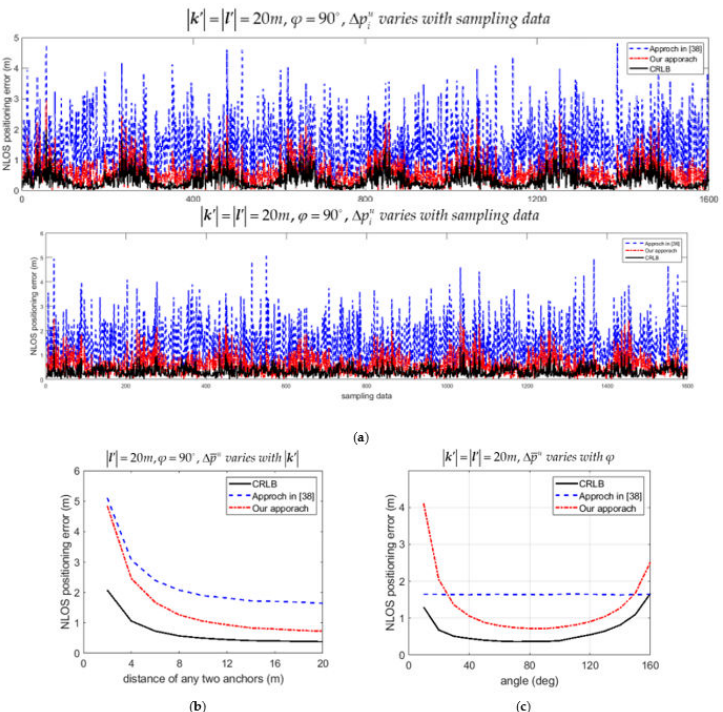
Figure 8. Comparison of upper bound of 2D positioning errors estimated by our approach and the approach in [38] for the NLOS condition. ( a ) Variation of ∆ p u (cid:12) (cid:12) with distance (cid:12) k (cid:48) (cid:12) ; ( c ) Variation of ∆ p u with angle ϕ